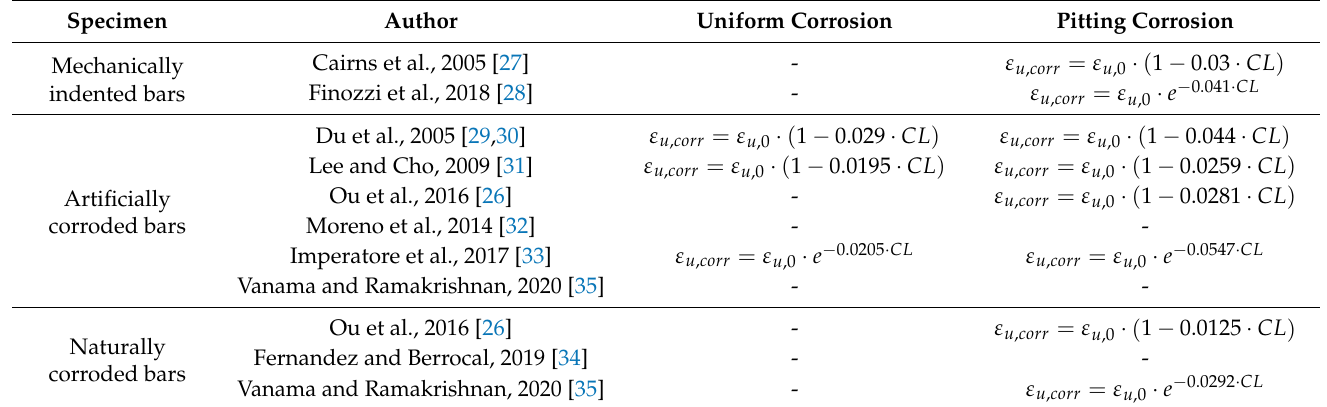
Table 2. Ultimate Strain degradation laws for uniform and pitting